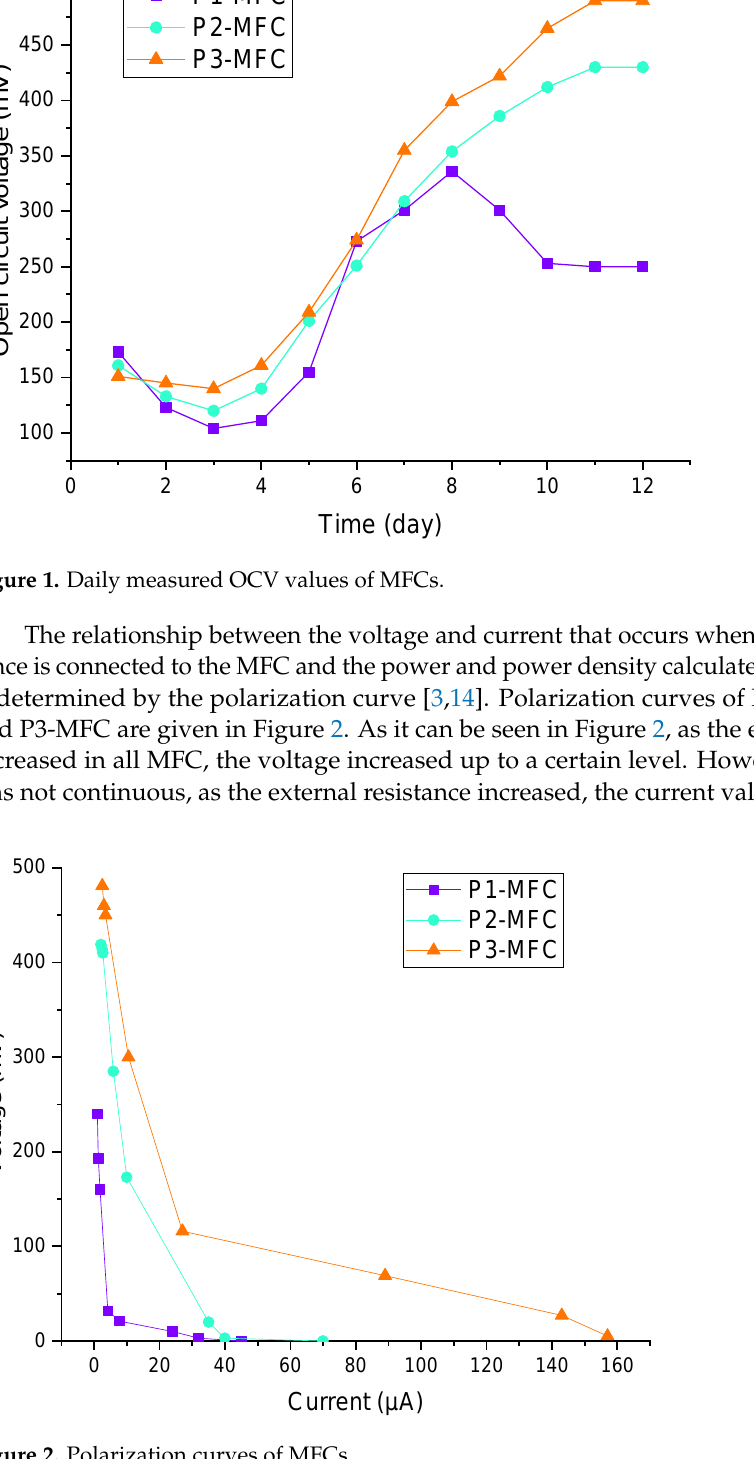
Figure 2. Polarization curves of MFCs.